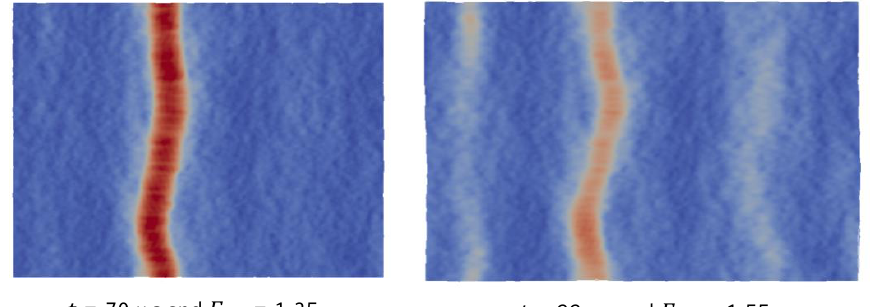
Fig. 4. Maps of Hencky strain 𝜀 𝑑𝑒𝑣 in average plane for the 50000 grain aggregate and plane strain stretching in the late stage for stretching rates 𝐹̇ 𝑋𝑋 = 5000 s -1 and 𝐹̇ 𝑋𝑋 = 25000 s -1 (same color scale